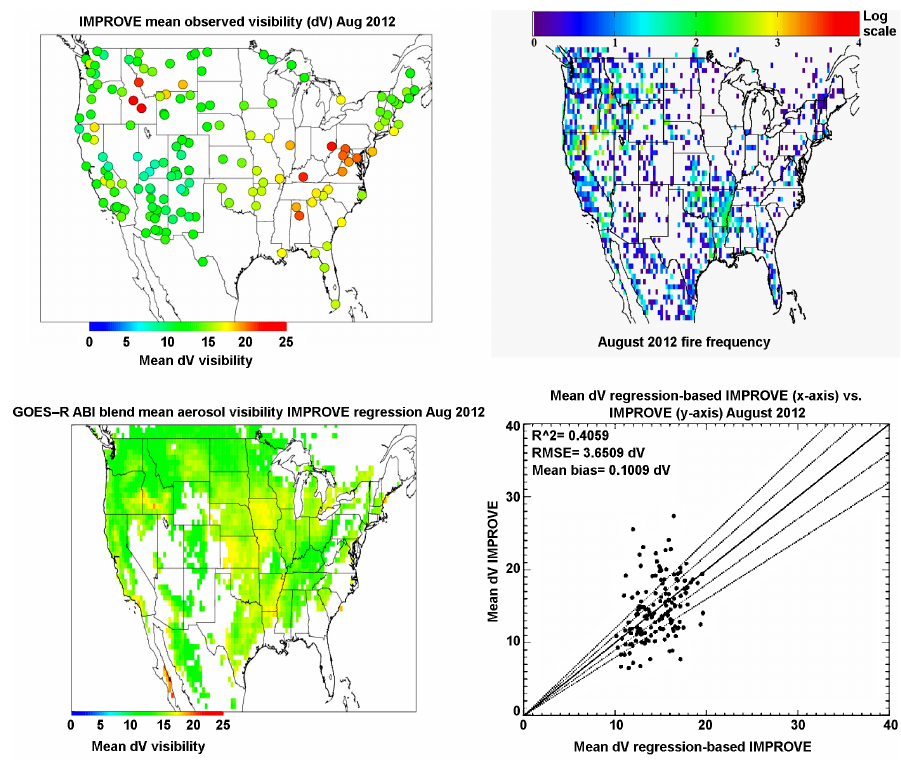
Figure 6. Top left panel: IMPROVE mean observed visibility (d V ) in the United States for August 2012; top right panel: WF-ABBA fire frequency in the United States for August 2012; bottom left panel: IMPROVE regression (bias-corrected) retrieval mean d V in the United States for August 2012; bottom right panel: scatter plot of collocated mean d V IMPROVE regression (bias-corrected) retrieval versus IMPROVE for all IMPROVE sites for August